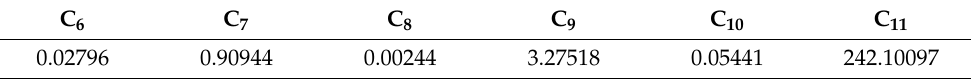
Table 3. Correlation constants for neutral oxygen compounds in Kukersite shale